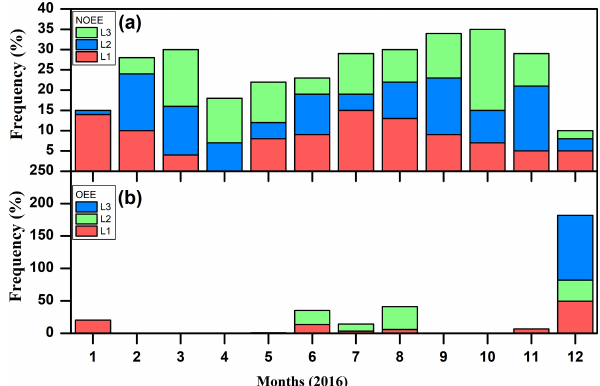
Figure 9. Monthly frequency distribution of clustering trajectories (Line 1, 2, 3) during NOEEs and OEEs.